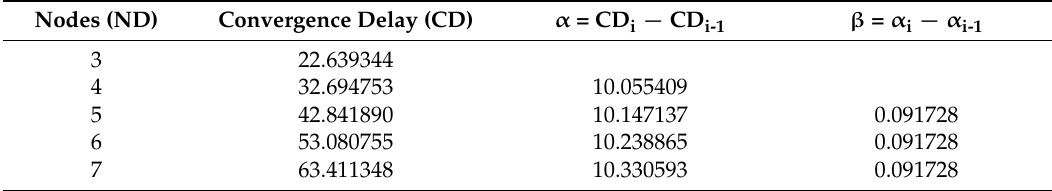
Table 5. Convergence Delay Analysis.